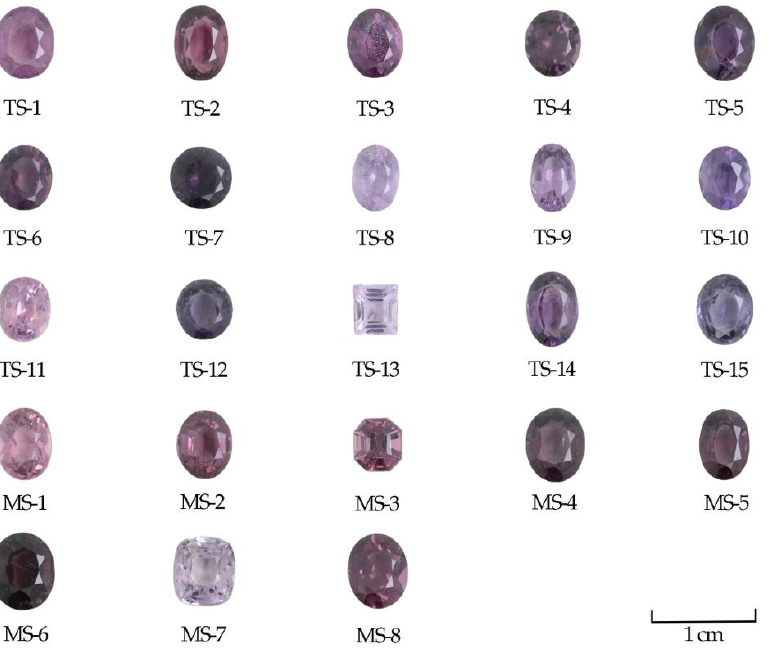
Figure 3. Purple-violet spinel samples in this study (TS: Tanzanian spinel; MS: Myanmar spinel). Table 1. Summary of gemological properties of Tanzanian and Myanmar spinels.